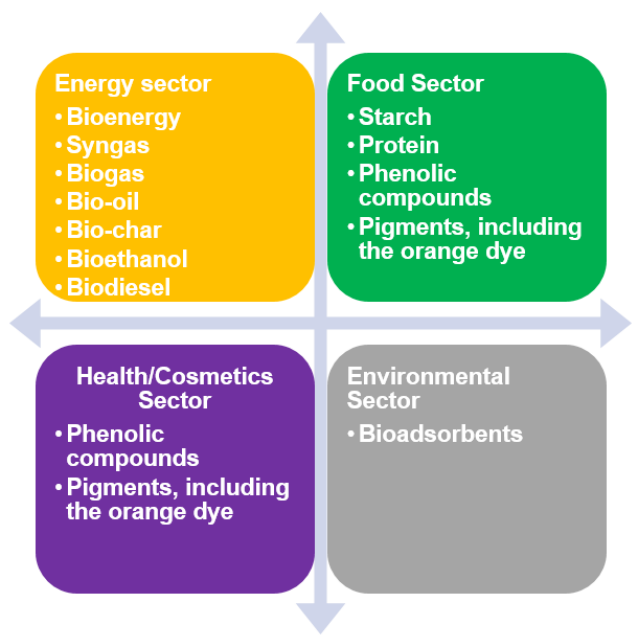
Figure 10. Summary of products that can be obtained from avocado waste and the sectors of application.